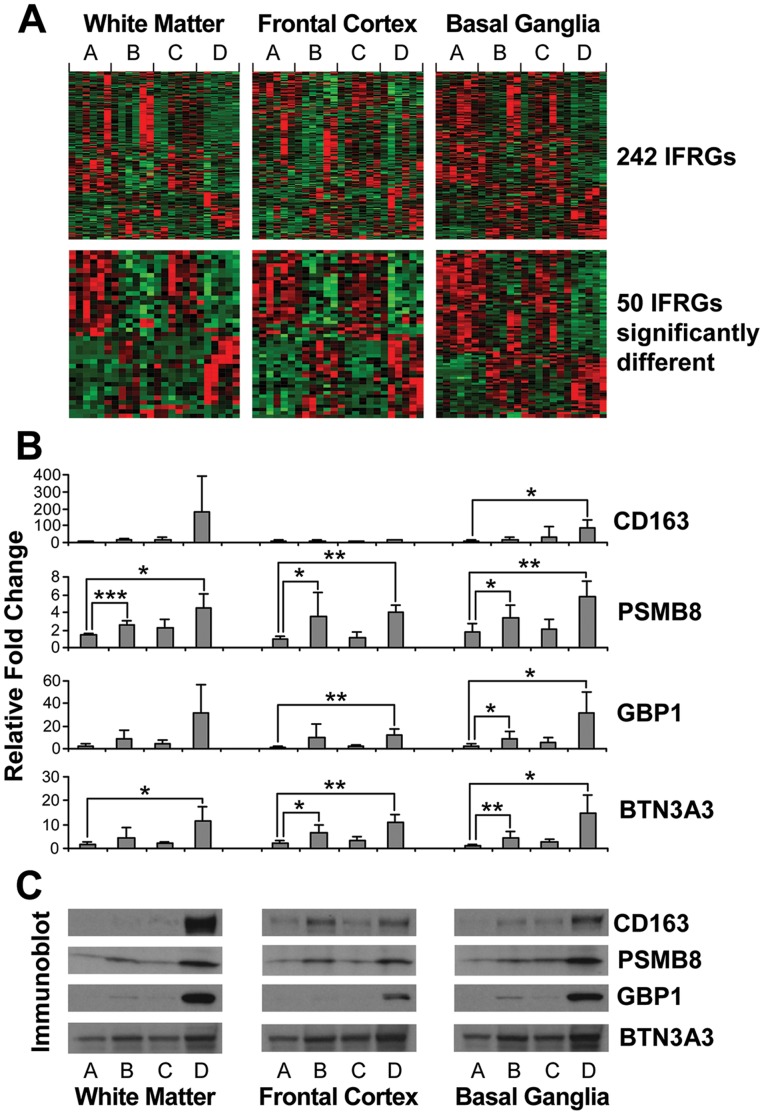
Interferon response genes (IFRGs) on the array.Four array groups are designated A, B C and D on the abscissa. The top panels contain heat maps of normalized signal intensities for 242 unselected IFRG probes, and for 50 IFRG significantly regulated probes. The heat maps illustrate clustering of IFRGs in the four groups. The B panels are histograms of real time PCR confirmation for three IFRG transcripts and CD163 (mean ± SD, Student’s t test). The C panels illustrate confirmation at the protein level in Western blots of pooled extracts. Group D (NCI with HIVE) had significant regulation of IFRGs in all three brain sectors. Group C (NCI without HIVE) did not have significant IFRG regulation. Group B (HIV-1-infected subjects without any impairment or HIVE) had mild IFRG regulation. *p<0.05; **<0.01; ***<0.001.